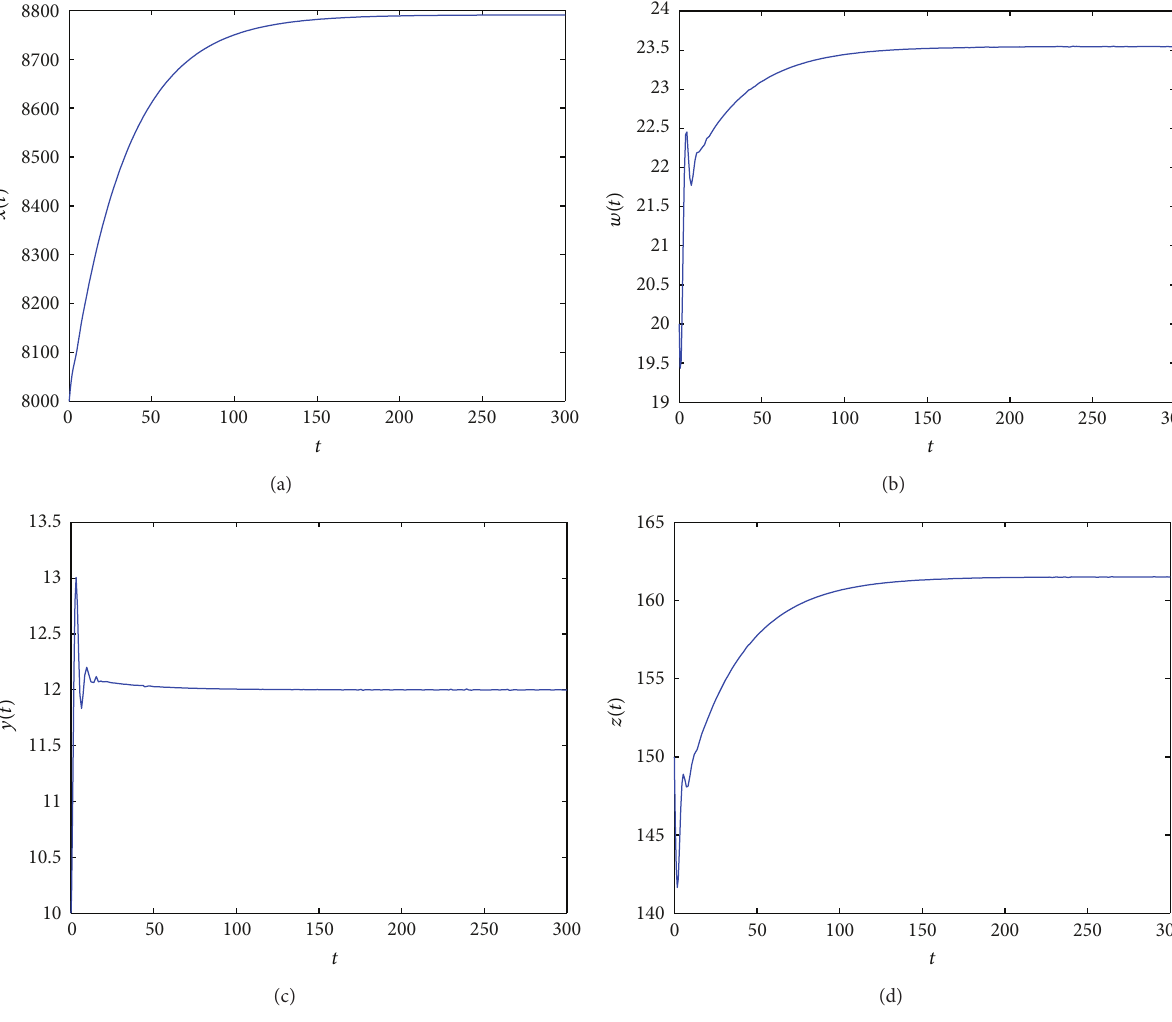
Figure 1: When 𝜏 = 0.2 < 𝜏 0 , the CTL-activated infection equilibrium 𝐸 ∗ (8790.7081, 23.5465, 12.0000, 161.5044) of system (2) is asymp- totically